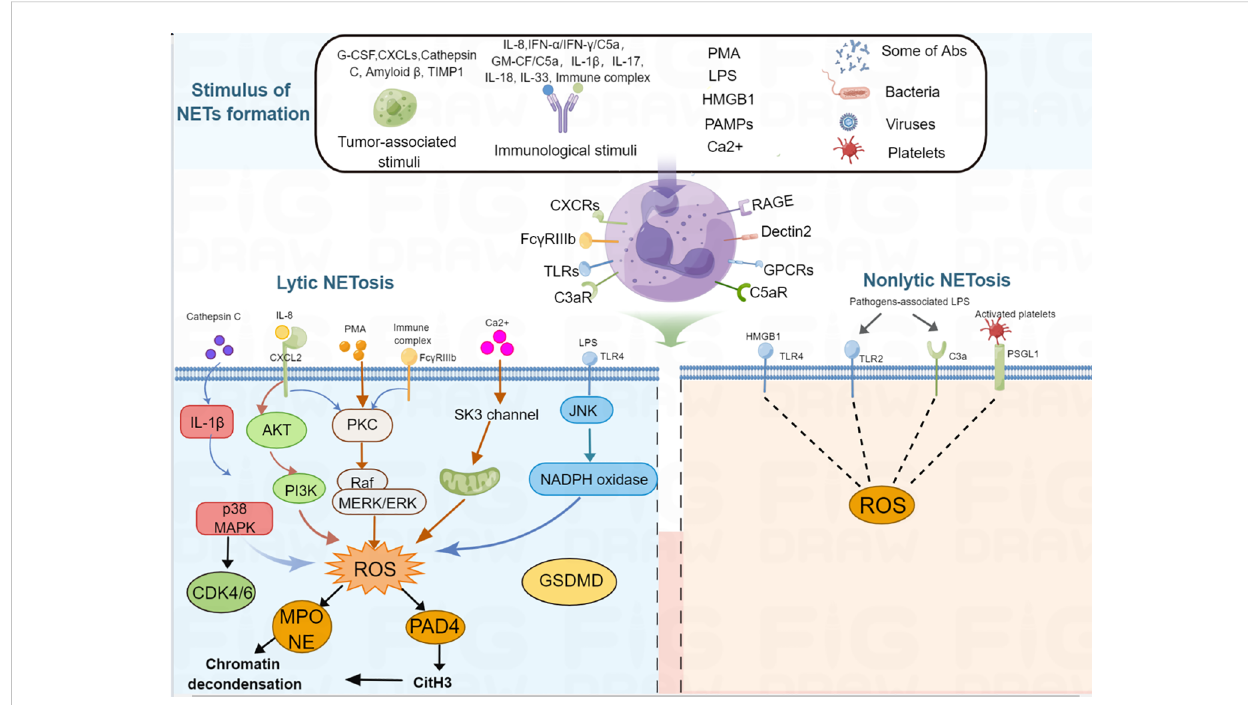
FIGURE 1 Schematic representation of NET formation. Different stimuli, such as PMA, tumor-associated stimuli, immunological stimuli, IL-1 b , IL-17, IL-18, IL- 33, LPS, PAMPs, some antibodies, activated platelets, bacteria, viruses, Ca2+ can induce NET formation. For lytic NETosis, external stimuli produce different kinds of ROS-inducing receptors, activating neutrophils to produce intracellular ROS, ROS further activates MPO and PAD4, then MPO activates NE and PAD4 citrullinates H3, therefore, leads to nuclear envelope disintegration, chromatin decondensation, cell membrane breakdown, NET formation. For non-lytic NETosis, some stimuli, such as Staphylococcus aureus and Candida albicans -associated LPS and HMGB1 can induce NET formation through a non-lytic